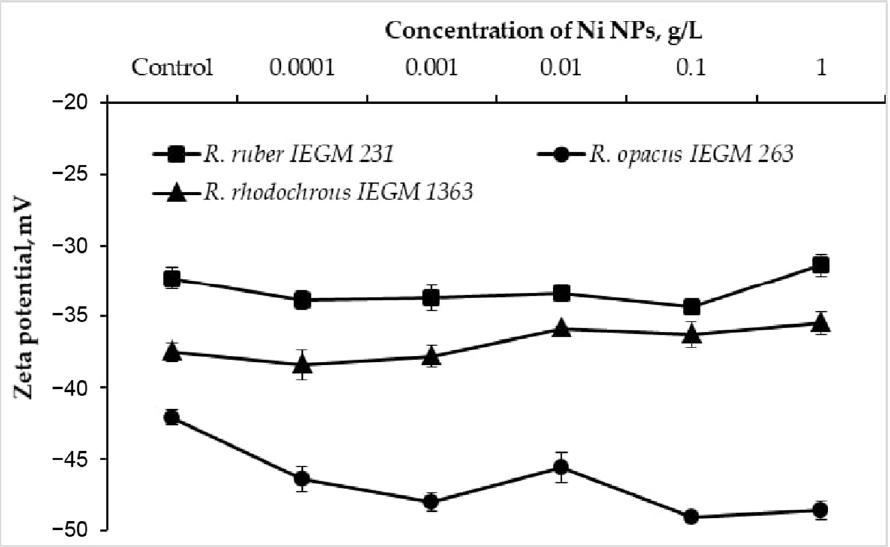
Figure 3. Zeta potential values of Rhodococcus cells incubated with different concentrations of Ni NPs.